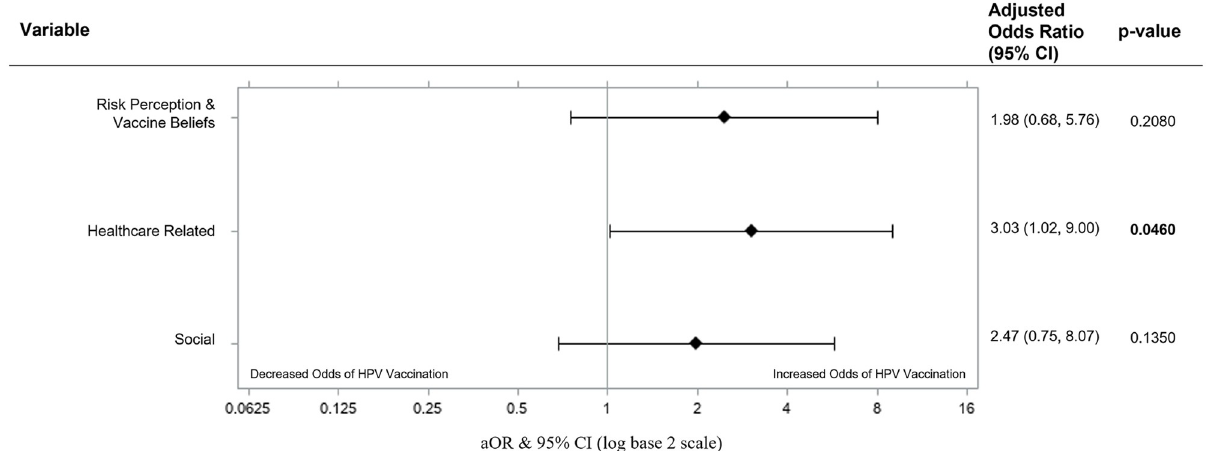
Fig 3. Motivators of HPV vaccination in multivariate logistic regression (Model 2, n = 84). Motivators of HPV vaccination in a multivariable logistic regression model containing risk perception & vaccine beliefs, healthcare related, and social motivators. Adjusted Odd Ratios of adverse events were calculated and presented using a log base 2 scale in a Forest Plot. Null line is indicated for no predictor effects and bolded lines represent adjusted odds ratio with 95% confidence intervals. Bolded lines above and below the null line indicate increased or decreased odds of adverse events, respectively.